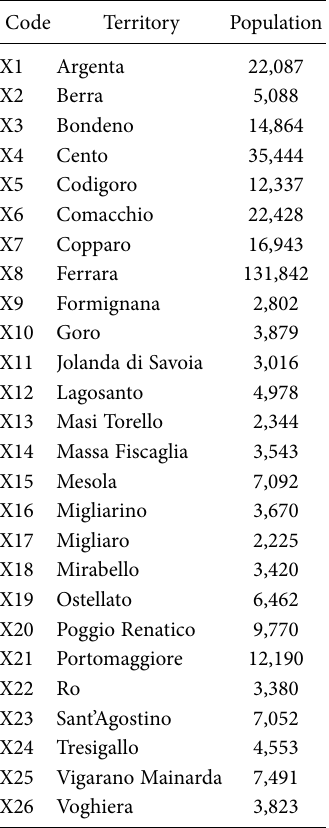
Table 1. Municipalities in the